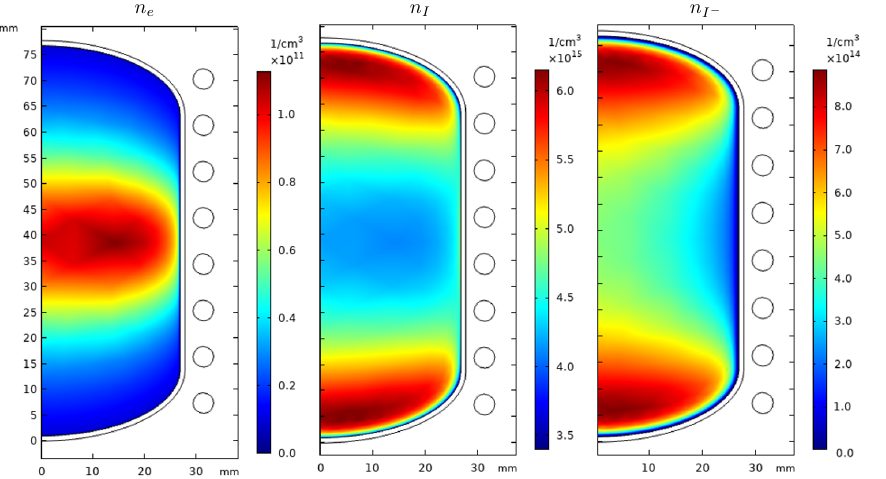
Figure 3. Comparison of different particle density distributions of the I 2 -Xe plasma at 400 W input power. Left : Electron density. Center : Atomic iodine density. Right : I − -density.